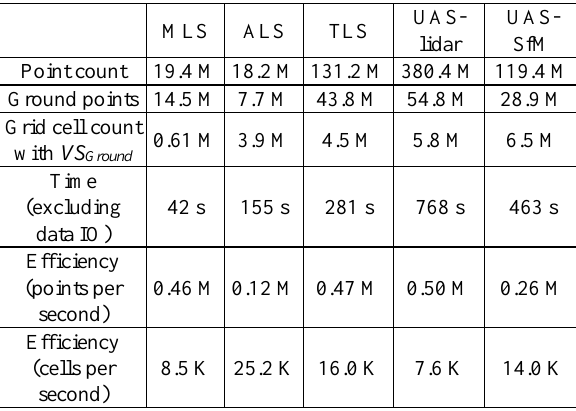
Table 1 Summary of the testing datasets and test